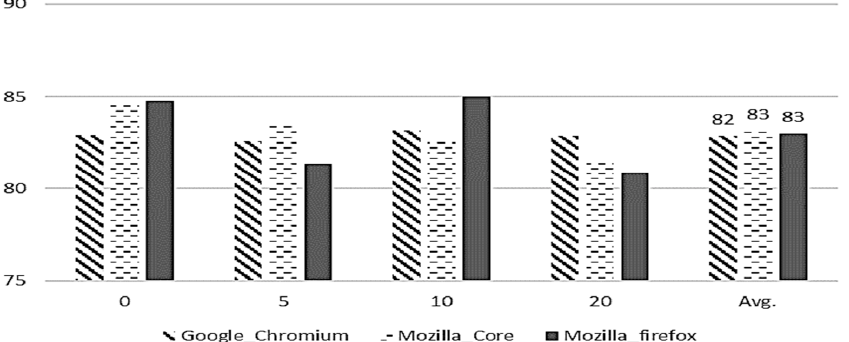
Figure 8. Precision result between for each project.